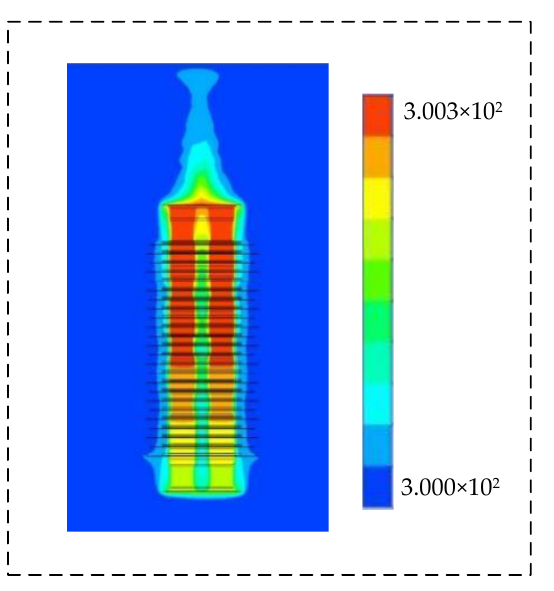
Figure 7. Steady-state temperature distribution of the arrester under monopole earth loop operation mode.